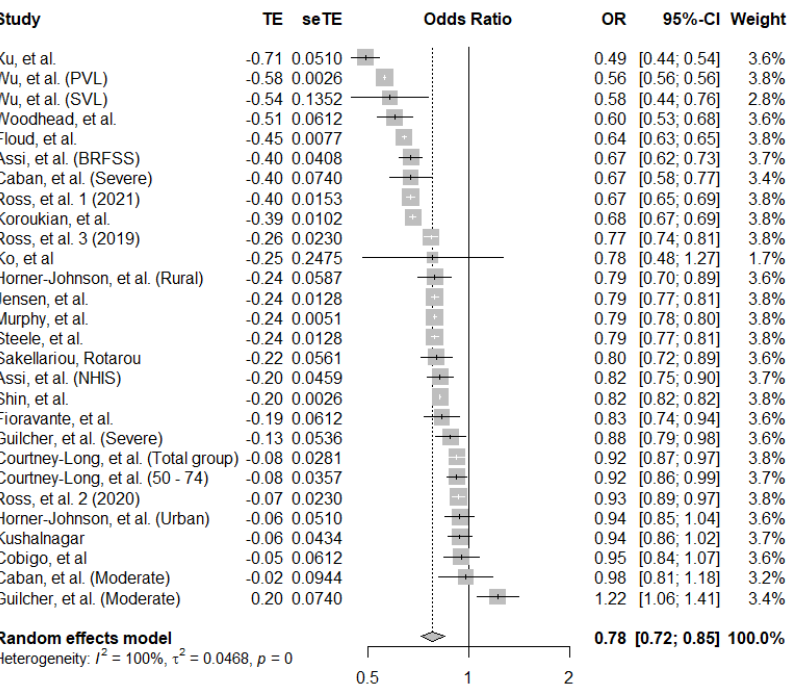
Figure 2. Pooled adjusted odds ratio estimates of breast cancer screening uptake by disability status